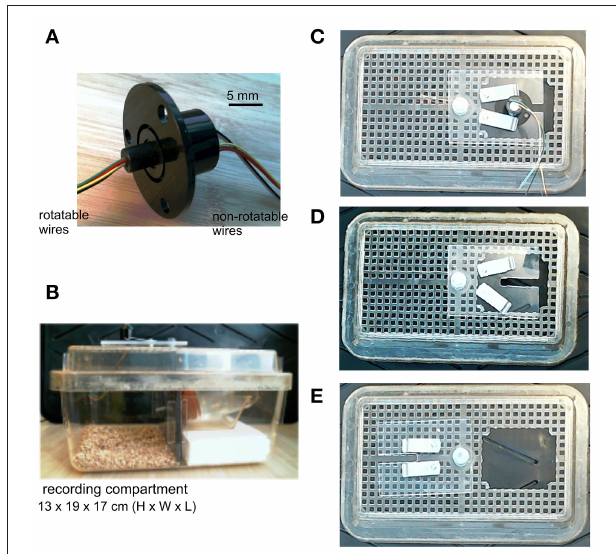
FIGURE 2 | Slip ring and modified mouse cage. (A) An image of the slip ring we used. The slip ring has six rotatable and non-rotatable wires and is 22 mm in flange diameter (part# 1528-1152-ND, Digikey, Canada). (B) A lateral view of the mouse cage which we modified. The cage was divided by a plastic glass into two compartments, one for animal housing/recordings and another for placing a water bottle. A narrow cut was made in the plastic glass that allowed the outlet of the water bottle to pass through. The slip ring was mounted onto a cage lid. (C) Bird’s eye views of the cage lid. The lid had an opening of 60 × 50 mm. A plastic glass plate, screwed onto the lid but movable horizontally, was used to cover the opening and to support the flange of the slip ring. Two small metal bars, screwed onto the glass plate but movable horizontally, were used to hold the slip ring by pressing onto its flange. (D) The slip ring was dismounted from the plastic glass plate. (E) The plastic glass plate was moved away to show the lid